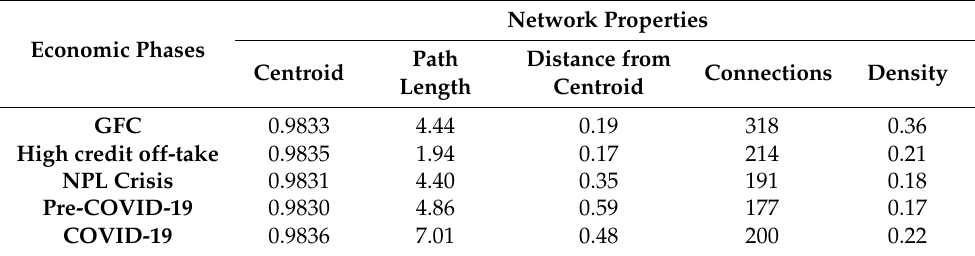
Table 2. Network properties for different economic